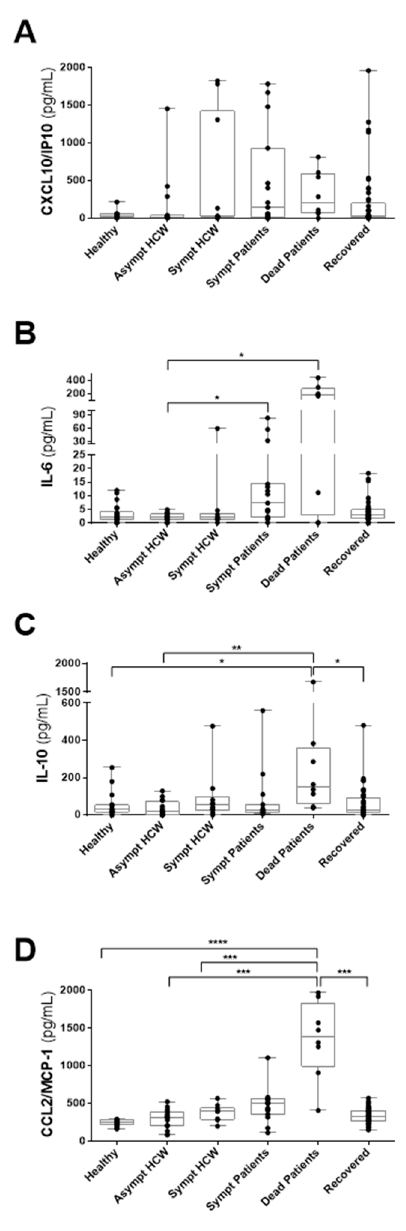
Figure 3. Comparison of CXCL10/IP-10, IL-6, IL-10 and CCL2/MCP-1 concentrations in different groups of HCWs and COVID-19 patients who have detectable anti-SARS-CoV-2 antibodies. Plasma samples from non-COVID-19 healthy individuals (n = 14–22), asymptomatic HCWs (n = 15–16), acute symptomatic HCWs (n = 10), acute symptomatic COVID-19 patients (n = 15), COVID-19 patients who died (n = 8) and patients recovered from COVID-19 (n = 44–45). ( A ) CXCL10/IP-10; ( B ) IL-6; ( C ) IL-10; and ( D ) CCL2/MCP-1. The box plots show the median (middle line), and the whiskers show minimum to maximum quartiles above and below the box. The p values were calculated using the Kruskal–Wallis test followed by Dunn’s multiple comparisons test. * p < 0.05; ** p < 0.01; *** p < 0.001; **** p <